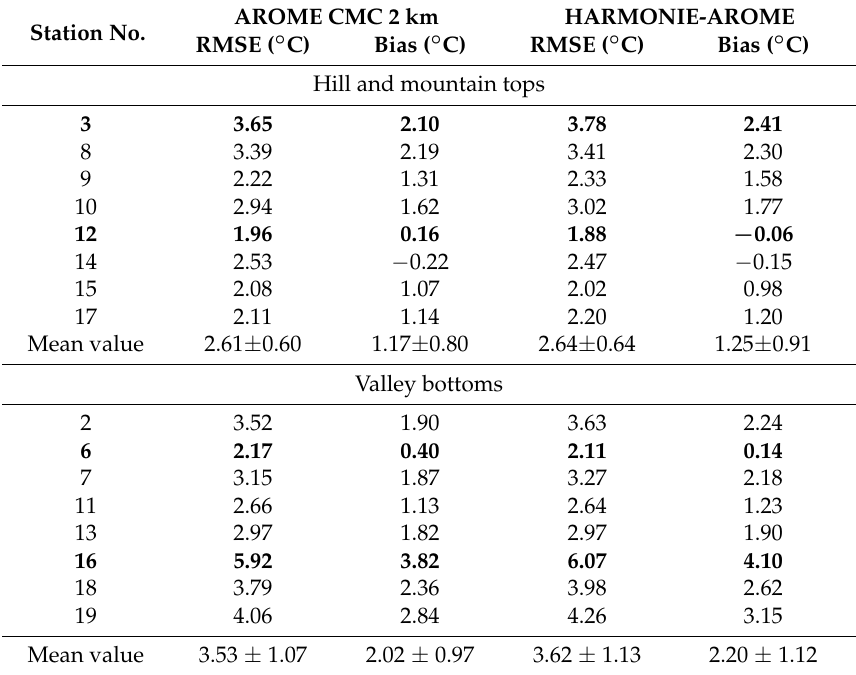
Data in bold signifies stations/points with highest and lowest RMSE value in each group.